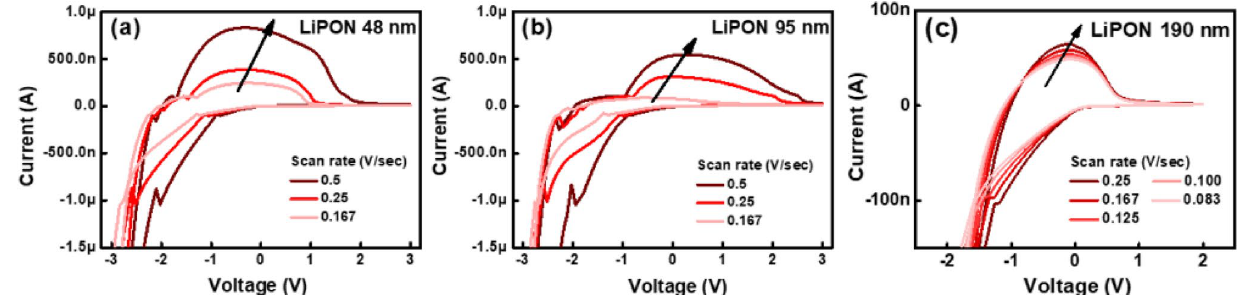
Figure 2. Cyclic voltammetry of three devices with LiPON electrolyte thickness of ( a ) 48 nm, ( b ) 95 nm, and ( c ) 190